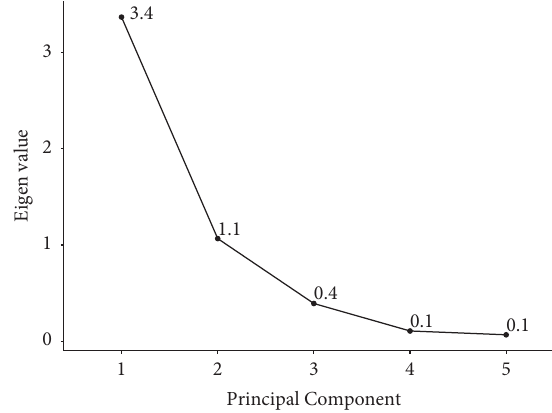
Figure 2: Scree plot of principal component analysis.